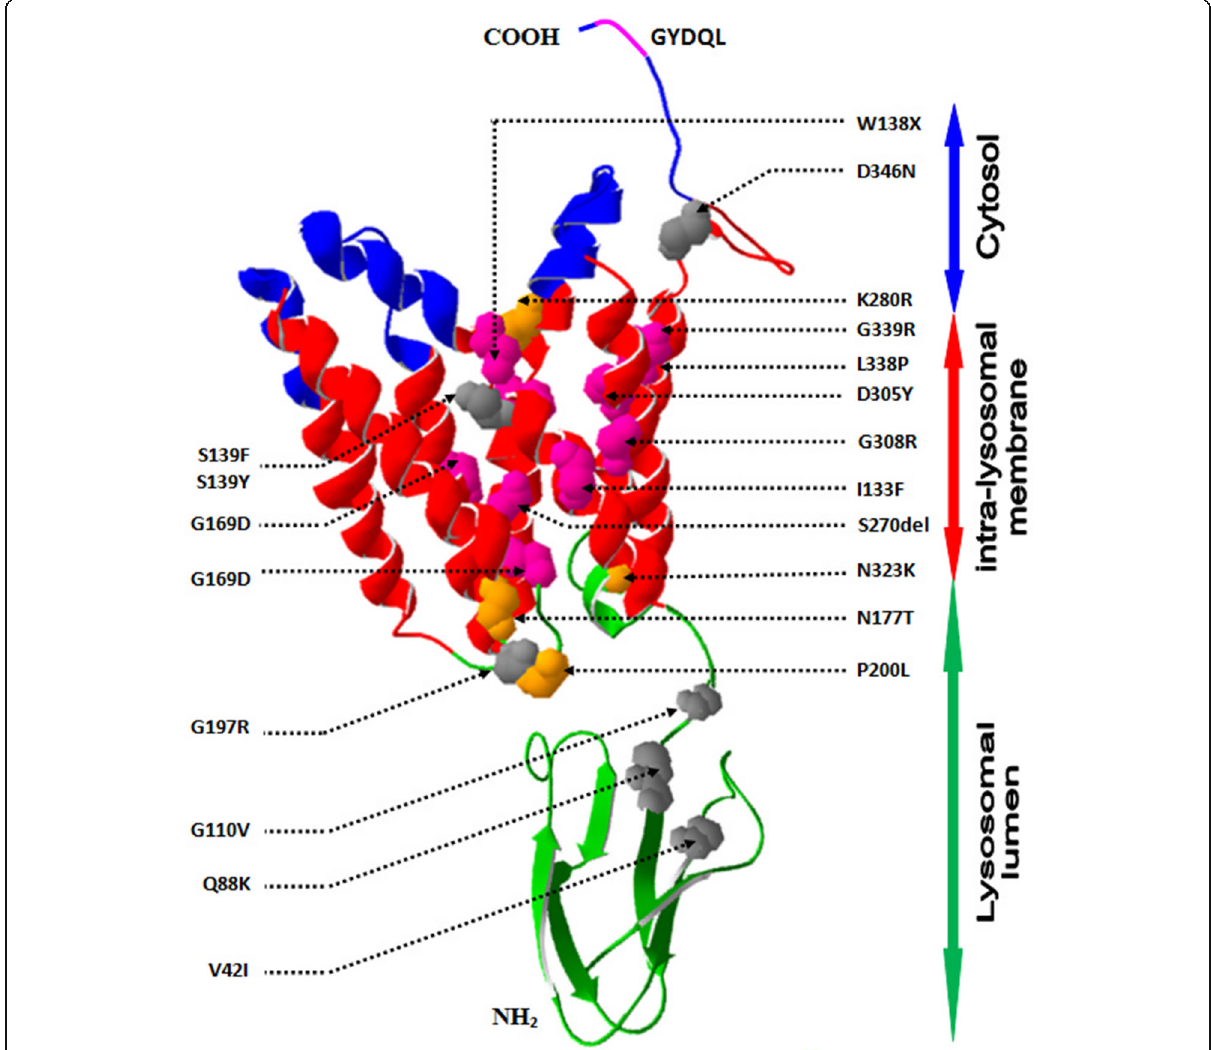
Fig. 2 Crystallographic structure analysis of the computer-generated 3D structure model of the human Cystinosin showing its putative topology and the reviously reported missense mutations. The localisation of the cystinosin regions in cytosol, intra-lysosomal membrane and lysosomal lumen are indicated by closed double arrow. The Transmembrane (TM) helices are colored in red in the ribbon structure, wherase the C-terminal tail and the N-terminal region are colored in blue and green, respectevely. Pink ribbon structure represents the lysosomal sorting signals: the GYDQL motif in the C-terminal tail. Previously described Infantile, Juvenile, Ocular and Atypical Cystinosis mutations are labeled and pointed by dotted arrow in the ribbon structure and colored in pink, orange, black and grey, respectevely. Molecules are oriented to best display all previously reported mutations The 3D structure file were generated from the protein homology modeling server SWISS-MODEL and the images were created using Swiss-PdbViewer 4.1.0 and POV-Ray 3.6